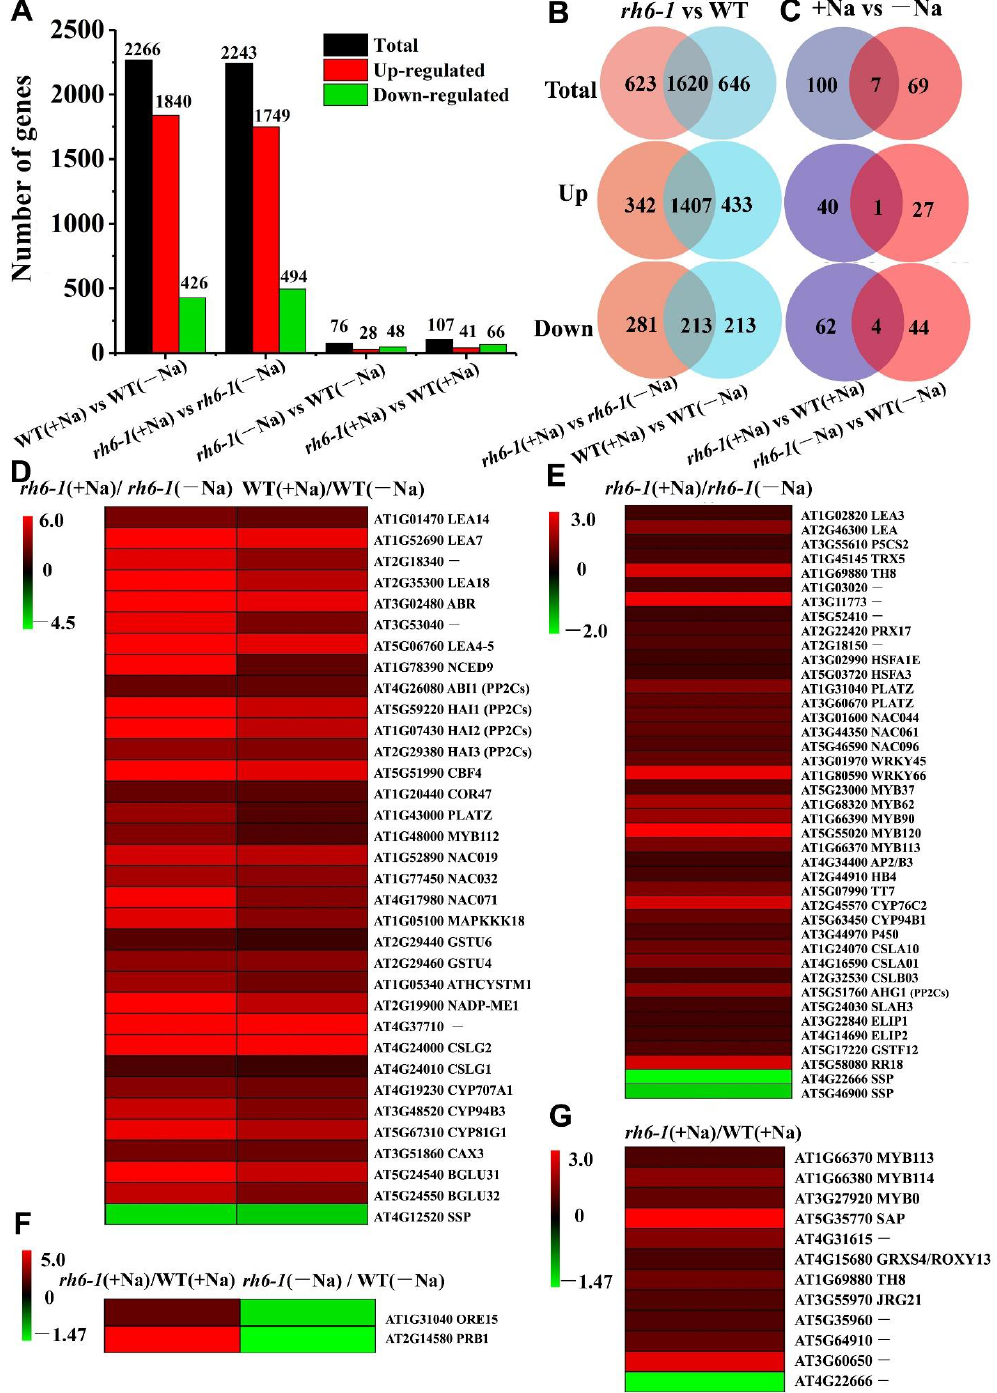
Figure 6. Differential genes in expression of WT and rh6-1 under salt stress determined by RNA-seq. ( A ) The number of differential genes in expression in four datasets. ( B ) Venn diagram showing total, up- and downregulated genes in Col-0 under 200 mM NaCl stress (+NaCl) relative to normal condition ( − NaCl), and in rh6-1 mutant seedlings under the same stress relative to normal condition. ( C ) Venn diagram showing total, up- and downregulated genes in rh6-1 seedlings relative to Col-0 grown under (+NaCl) and ( − NaCl). ( D ): Heat map of 34 co-expressed genes in WT(+Na) vs. WT( − Na) and rh6-1 (+Na) vs. rh6 - 1 ( − Na) datasets. ( E ) Heat map of 41 unique genes of rh6-1 (+Na) vs. rh6 - 1 ( − Na) dataset. ( F ): Heat map of 2 co-expressed genes in rh6 - 1 ( − Na) vs. WT( − Na) and rh6 - 1 (+Na) vs. WT(+Na) dataset. ( G ): Heat map of 12 unique genes of rh6 - 1 (+Na) vs. WT(+Na)